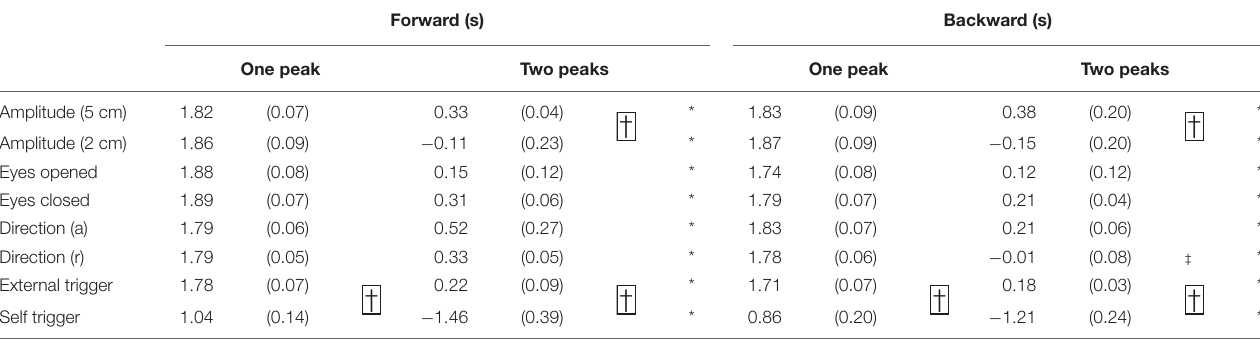
TABLE 8 | Onset latency of one- and two-peak EDR.